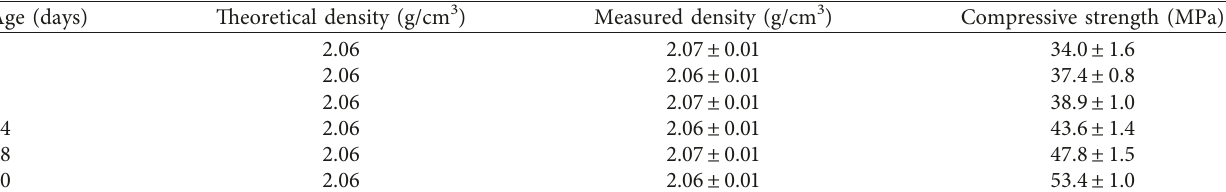
Table 4: Density and compressive